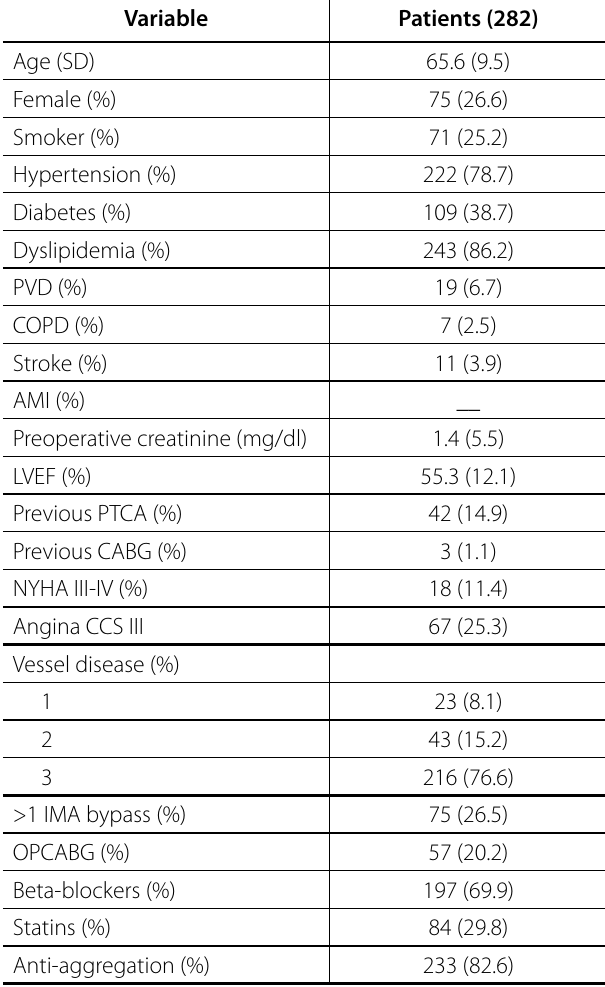
Table 1 . Basal demographics of included patients